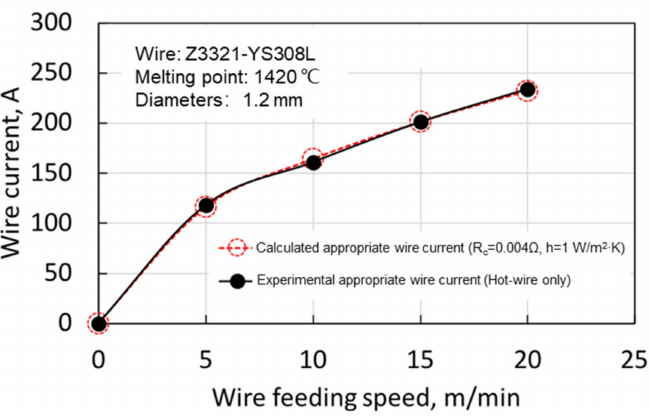
Figure 5. Comparison between calculated and experimental appropriate hot-wire current.